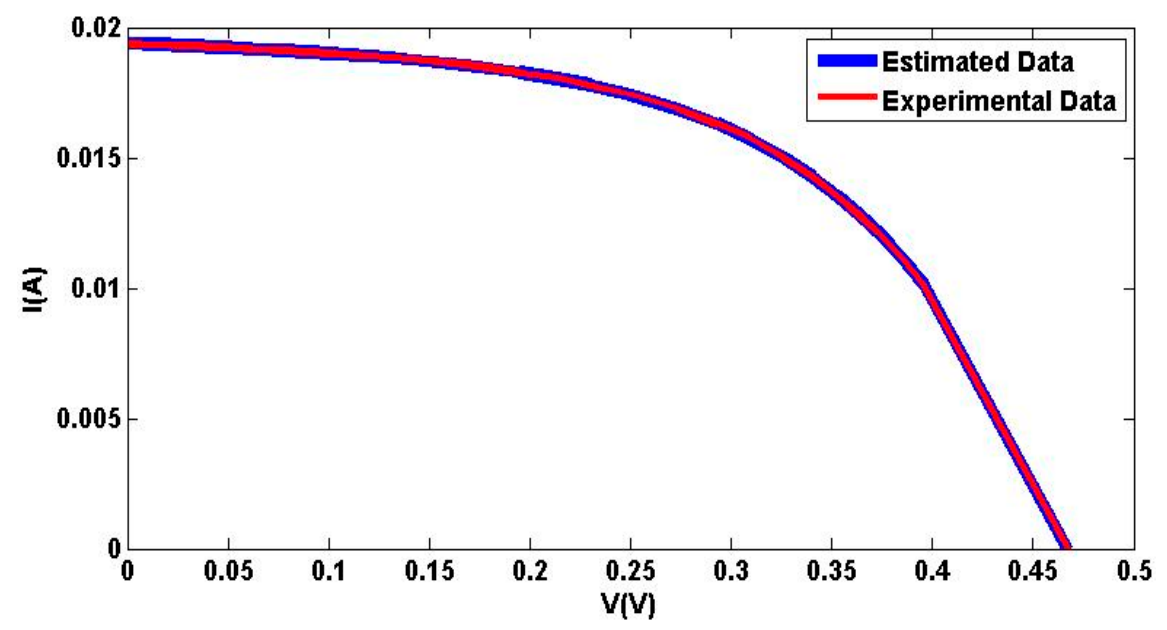
Figure 7. Experimental versus estimated (I–V) characteristic for MDDM using EHO.